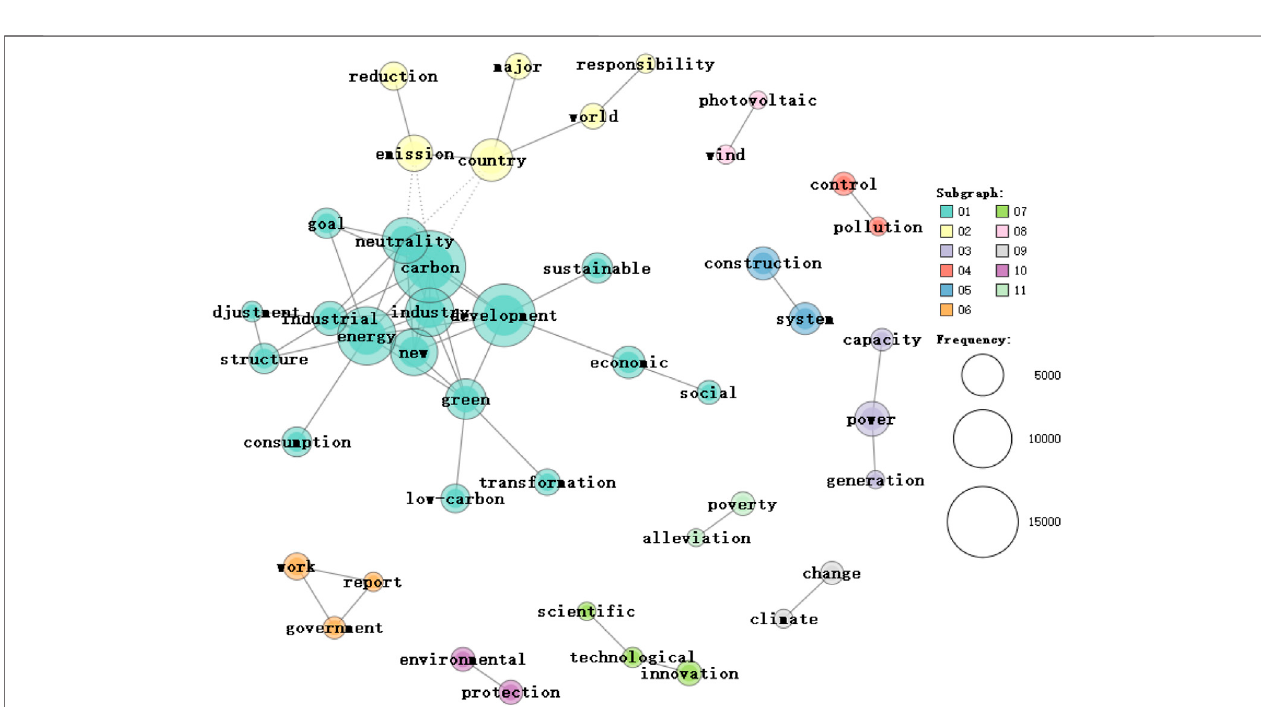
FIGURE 3 | Co-occurrence network